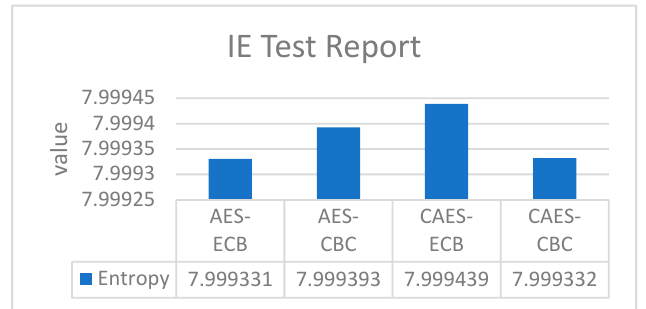
Figure 12. Information entropies for comparison.